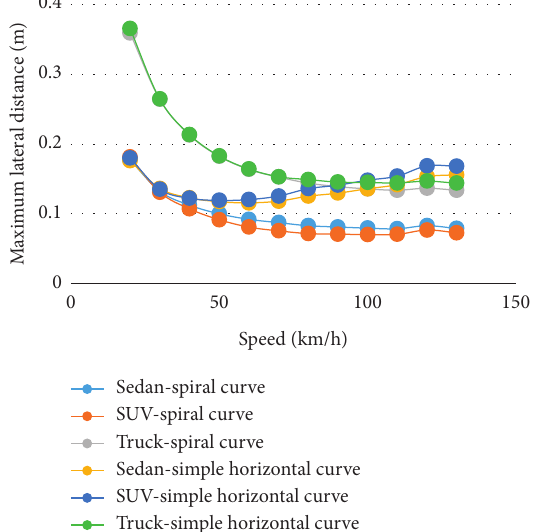
Figure 27: Comparison between the maximum lateral distances in the simple and horizontal curves versus the speed at radius R